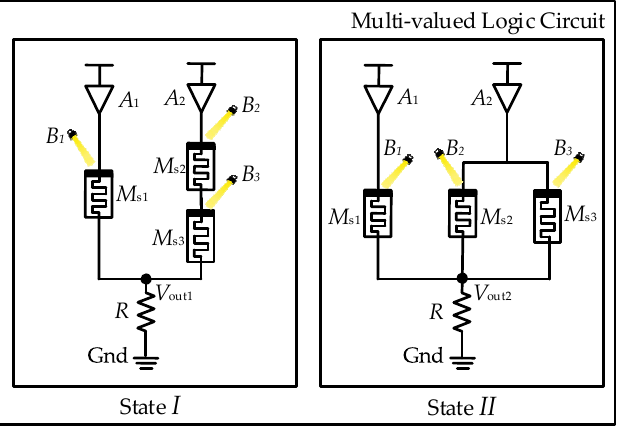
Figure 6. The circuit diagram of rotation mechanism.